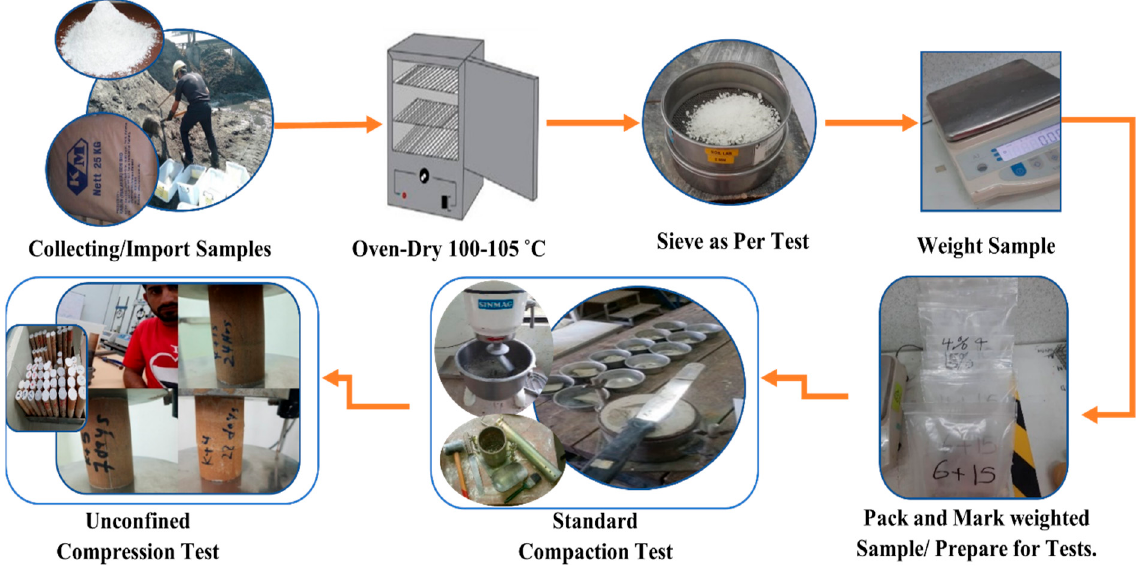
Figure 3. Experimental laboratory workflow.